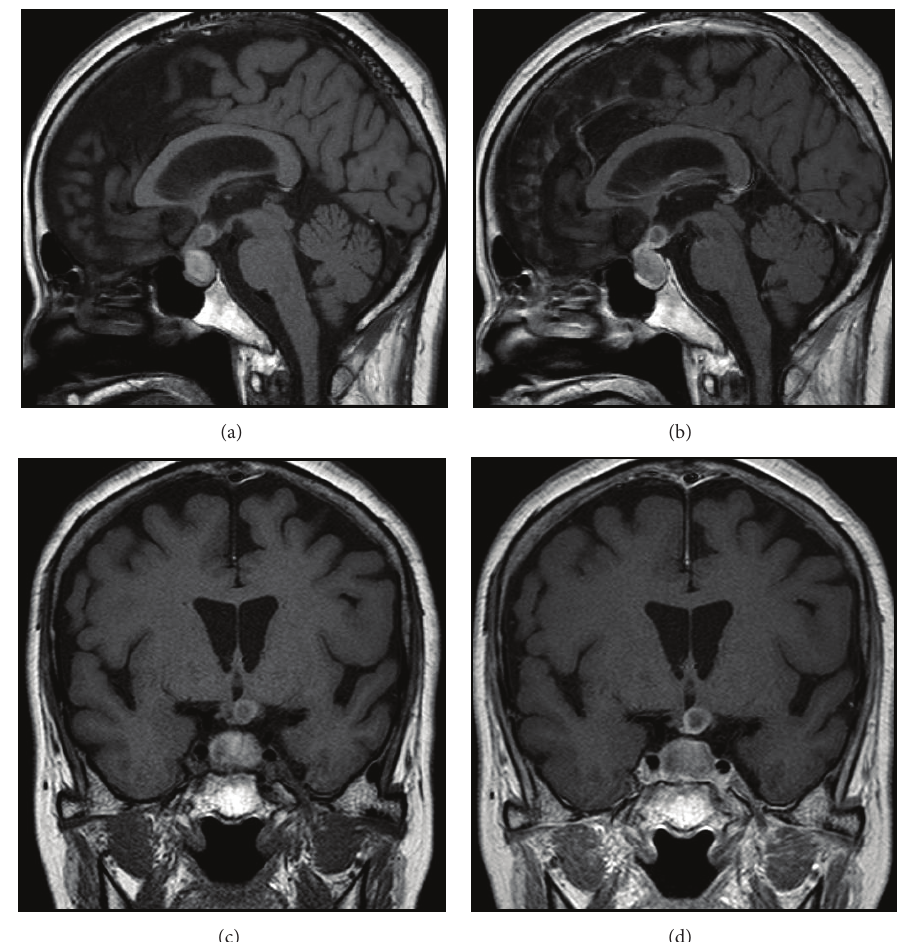
Figure 3: Brain MRI (T1-weighted images). Sagittal views of (a) plain and (b) Gd-enhanced images and coronal views of (c) plain and (d) Gd-enhanced images are